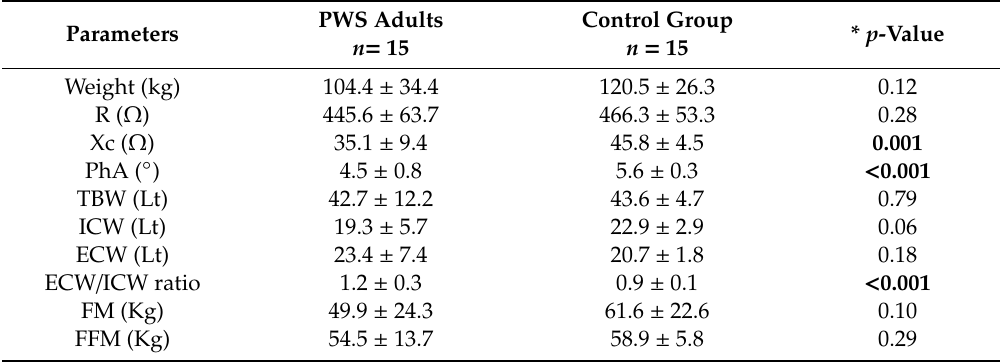
Table 1. Weight and body composition parameters of the study population assessed by bioelectrical impedance analysis in PWS adults and control